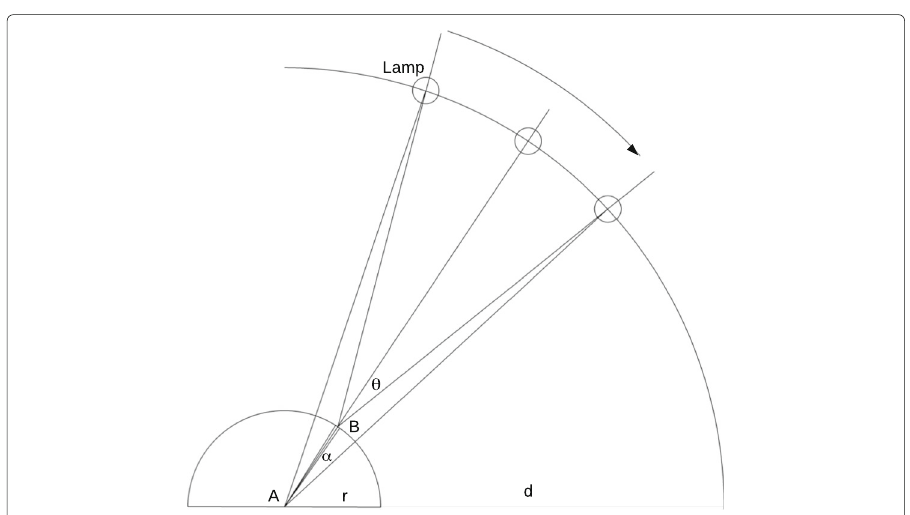
Fig. 7 Schema of angles and distances in the angular response setup. A: Centre of the entrance optic; B: Optical fibre aperture; r: Radius of the entrance optics (MDIO); and d: distance between the lamp and the entrance